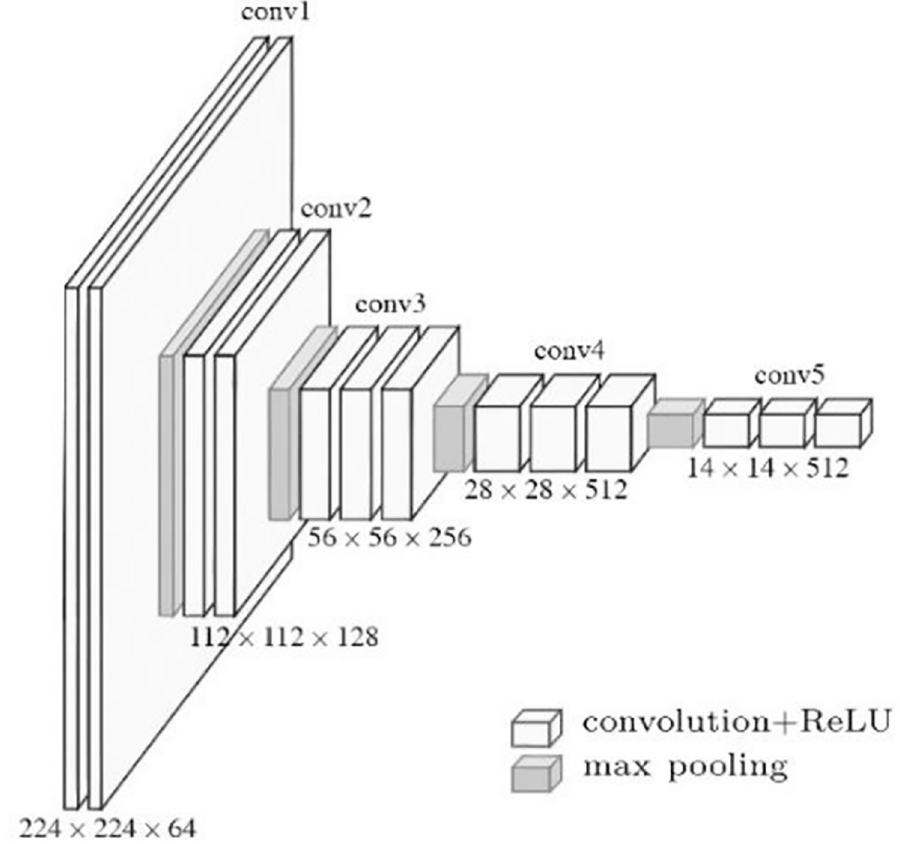
Fig 2. Structure diagram of VGG-16.